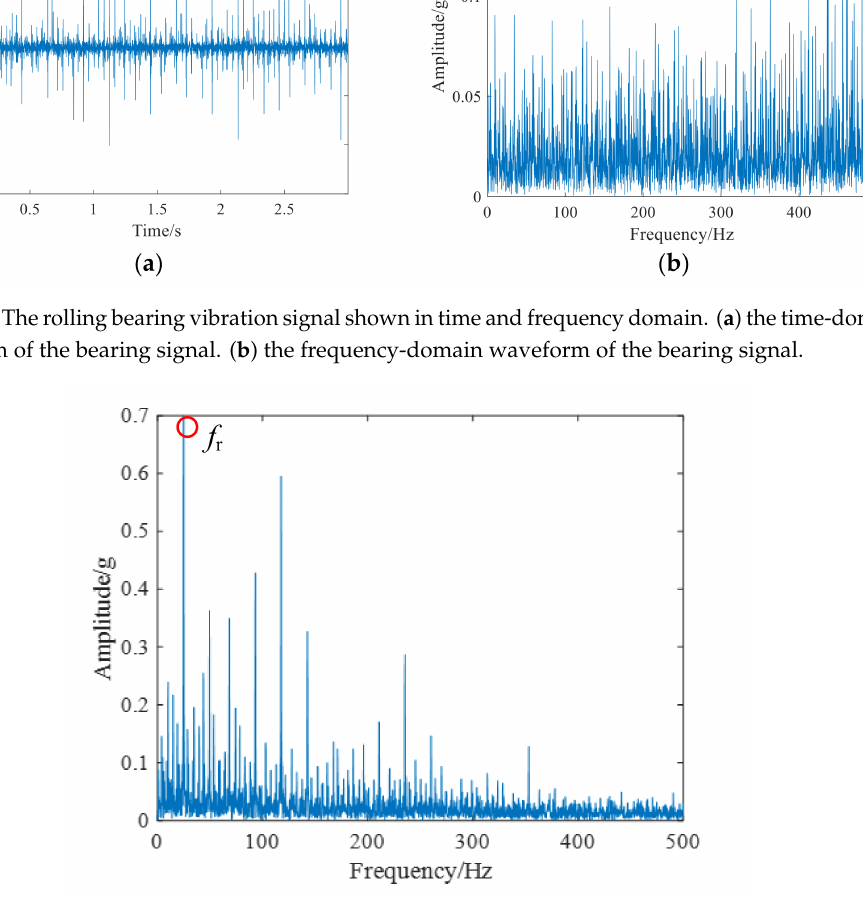
Figure 9. The envelope spectrum analysis results.